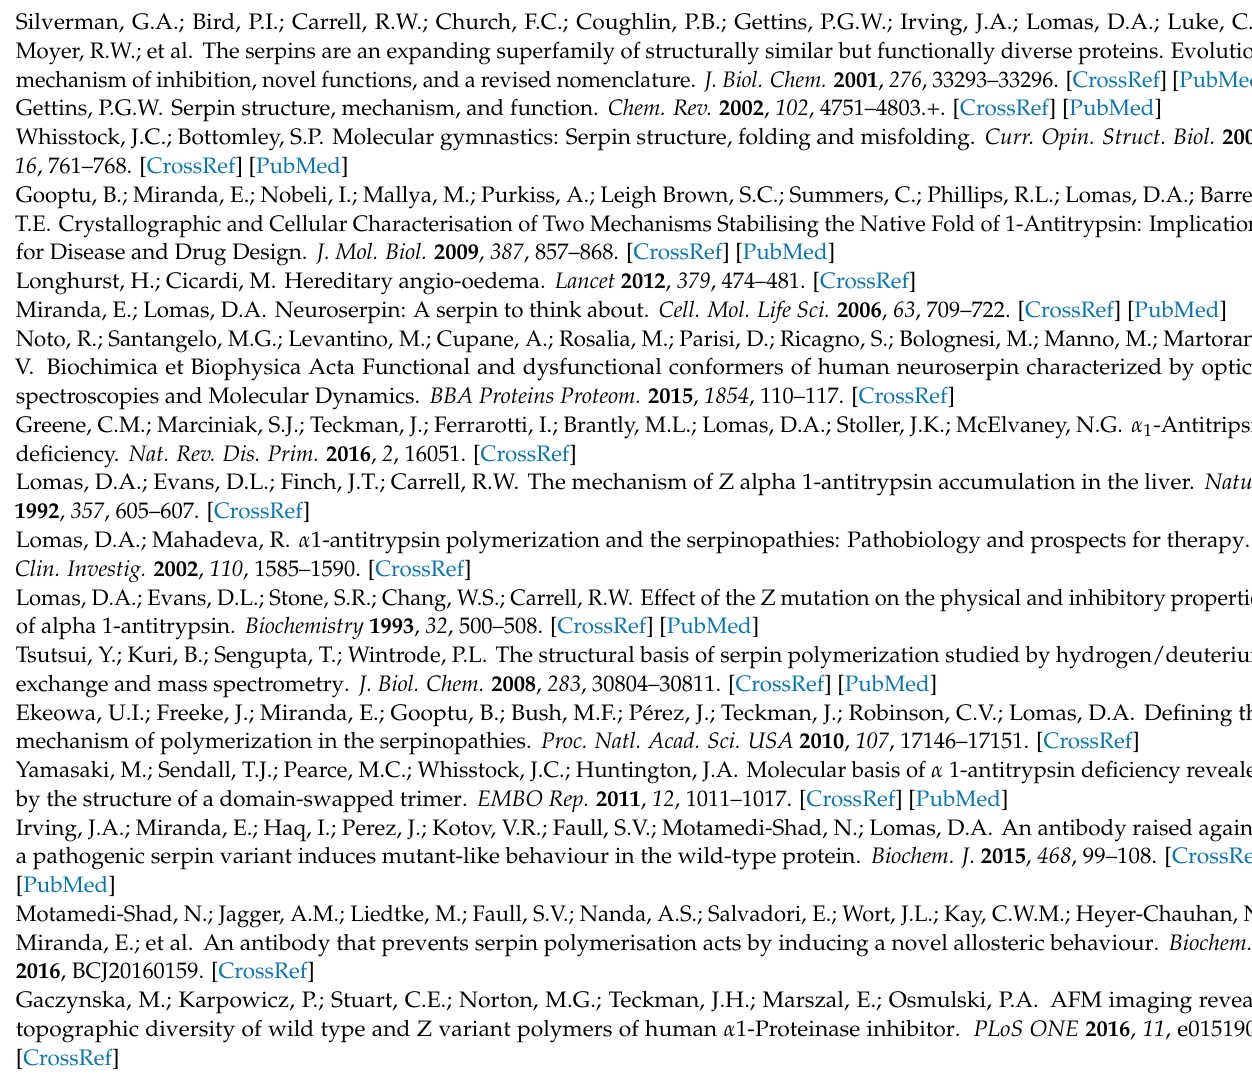
kinetics; Figure S8: Form factor and diffusion of α 1 AT polymers; Figure S9: Application of the worm-like chains (WLC)